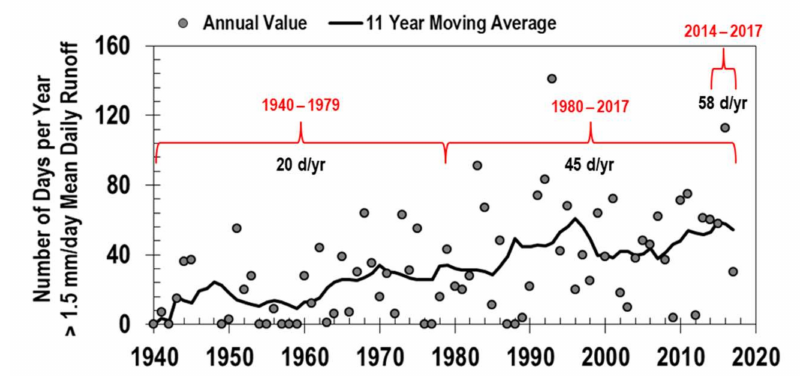
Figure A6. Number of days each year when mean daily flows are greater than the magnitude of the 1.5 mm/day or 1.2-year recurrence interval event. Daily data from USGS gage 5320500. Black line indicates an 11-year moving window average through the annual data points. Red bars indicate average annual values for the periods 1940–1979, 1980–2017, and